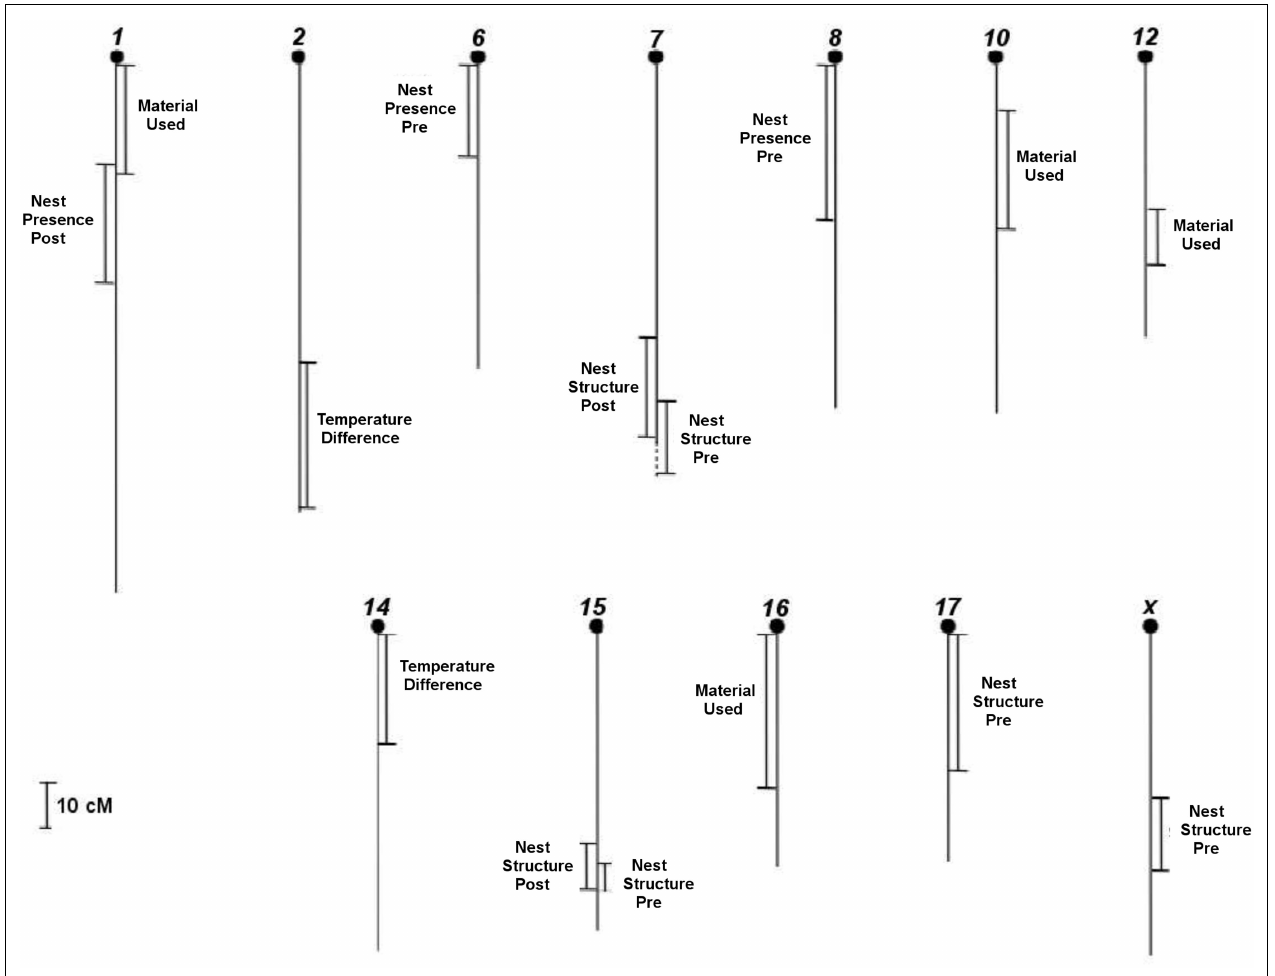
FIGURE 2 | Location of all direct-effect QTLs that we found in F 2 females in 12 chromosomes of 20 total from mice genome for the nest building phenotypes pre- and postpartum with respective confidence intervals, in cM.